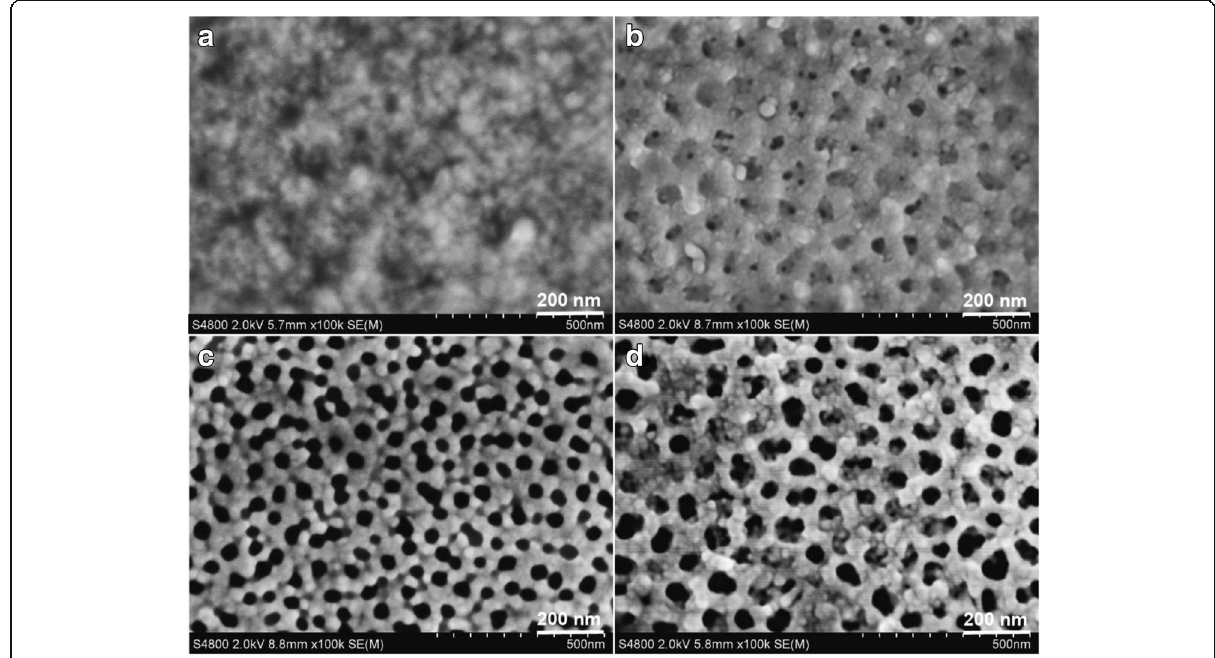
Fig. 5 SEM images of the ZnO films prepared on PAA with different time of two-step anodization duration a 0 min, b 40 min, c 60 min, and d 80